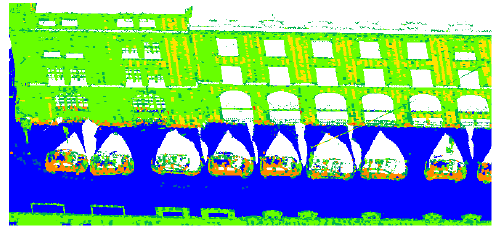
Figure 10. Result of the feature-based classification on the Testset 1